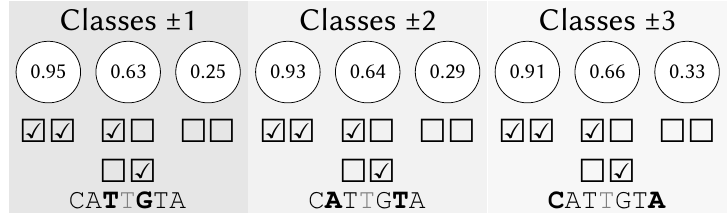
Figure 1. Learning example input vector for the ML-based